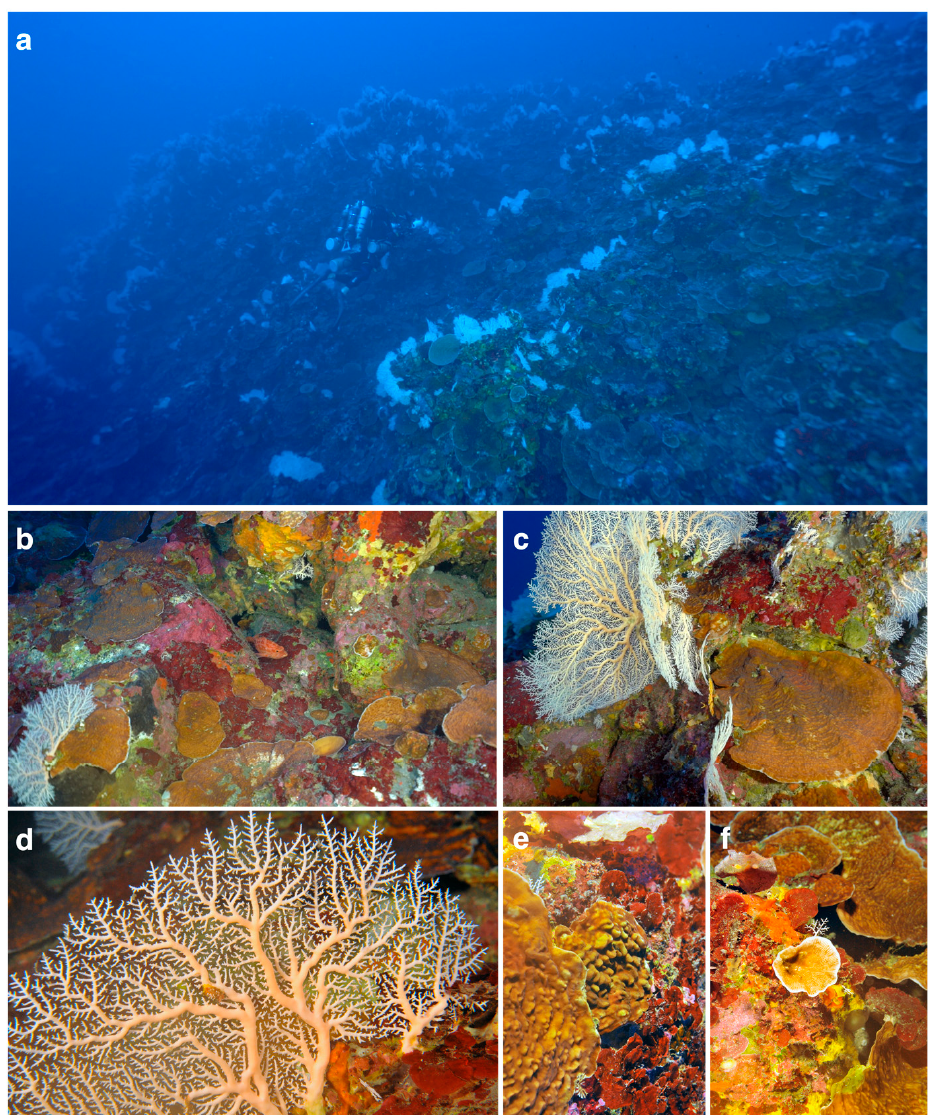
Figure 1. Benthic community on lava flow at 83–95 m depth on the leeward eastern coast of Reunion Island (Sainte-Rose) composed of dense aggregations of tall lace corals Stylaster flabelliformis and large zooxanthellate scleractinian corals Leptoseris spp. ( a ) Overall Mesophotic Coral Ecosystem (MCE) overview on the lava flow steep slope extending down to 100 m depth ( Stylaster colonies in white). Close-up views of large plates of ( b ) Leptoseris spp. and ( c ) S. flabelliformis above a large plate and encrusting colonies of Leptoseris sp. along with sponges, crustose coralline, and turf and macro-algae. ( d ) Colony close-up view of S. flabelliformis . ( e , f ) The diversity of Leptoseris spp. composed with thin plates, encrusting, vases, and tiered